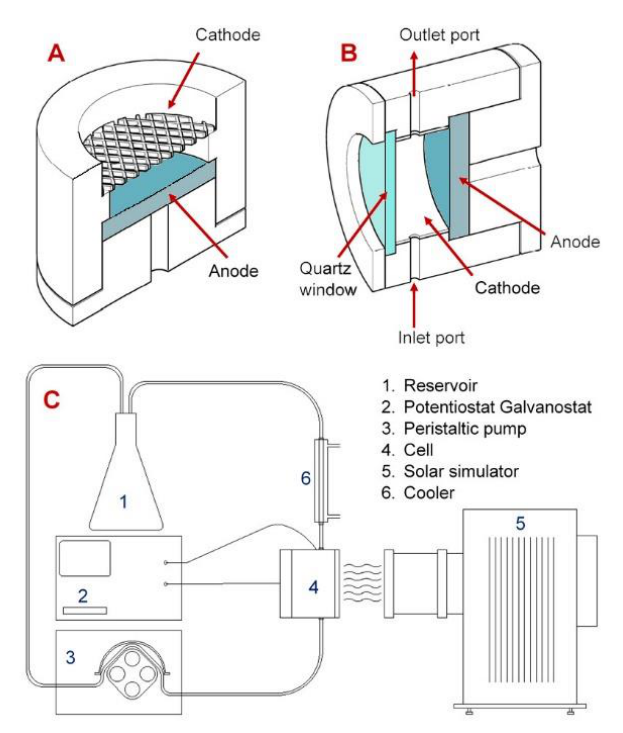
Figure 11. Axonometric sections of the cells used in anodization ( A ) and in photo-electrochemical tests ( B ); sketch of the apparatus used for photo-electrochemical experiments ( C ).